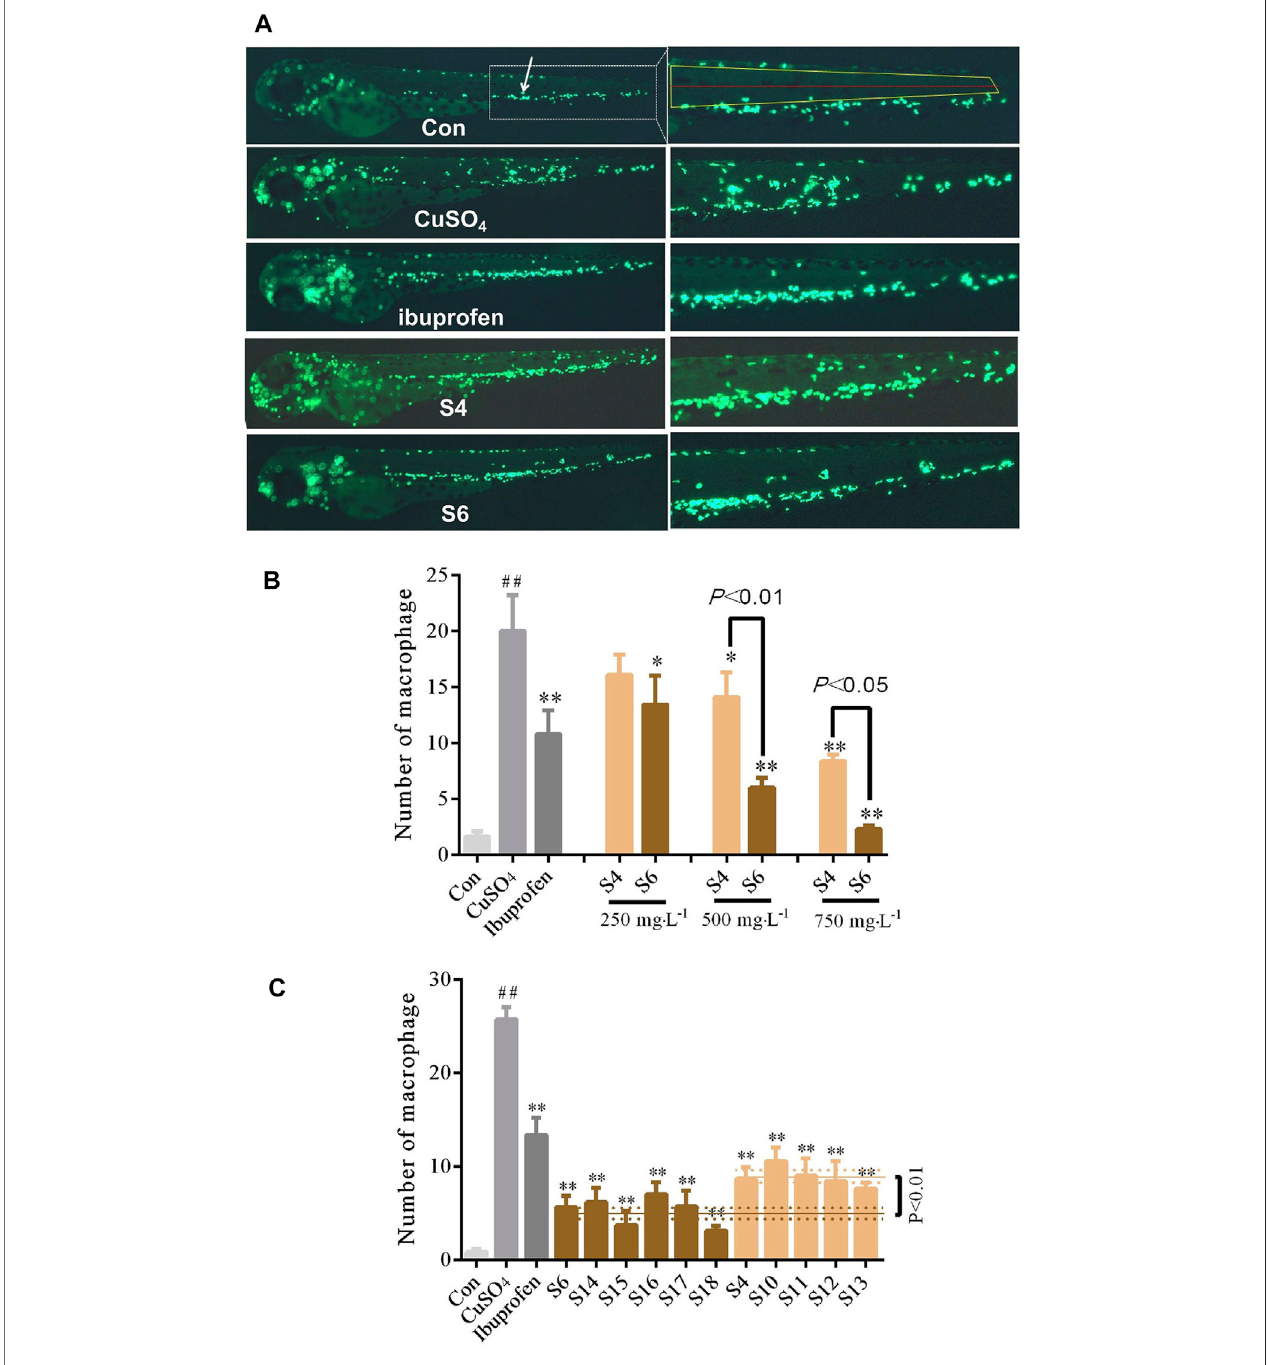
FIGURE3| Comparisonoftheanti-in fl ammatoryactivitiesofGF(S4andS6)collectedfromspeci fi clocations (A) Distributionphenotypicmicrographofneutrophils inzebra fi shandenlargeddrawingofneutrophilsspreadingtothelateralneuromastofthetail.at × 32magni fi cation (B) Comparativeanalysisoftheeffectsofin fl ammation inhibition in zebra fi sh treated with S4 and S6 of different concentrations (C) Multiple batches ’ comparison of anti-in fl ammatory effects of GF from two locations: Panan and Jichun. n (cid:2) 10.